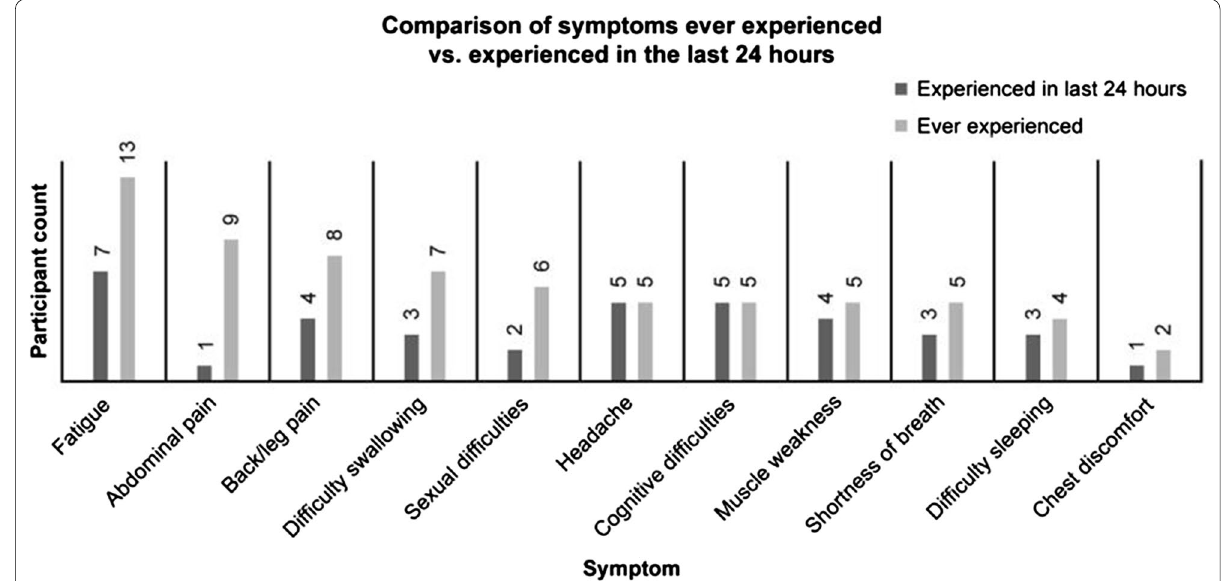
Fig. 3 Frequency of PNH symptoms experienced. PNH paroxysmal nocturnal